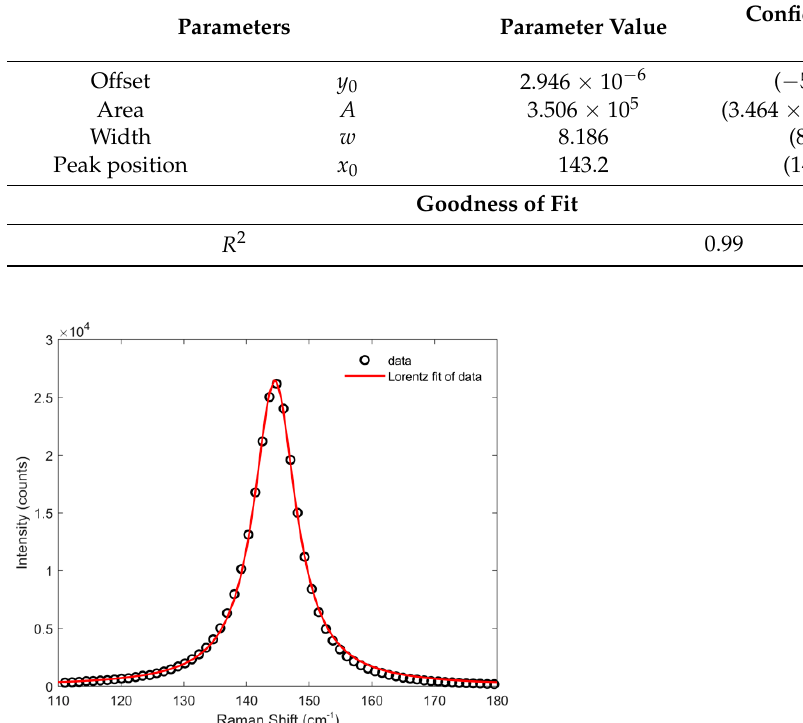
Table A1. Fitting model, parameters and goodness of the fit of TiO 2 Raman spectrum at 514.5 nm. Fitting Model